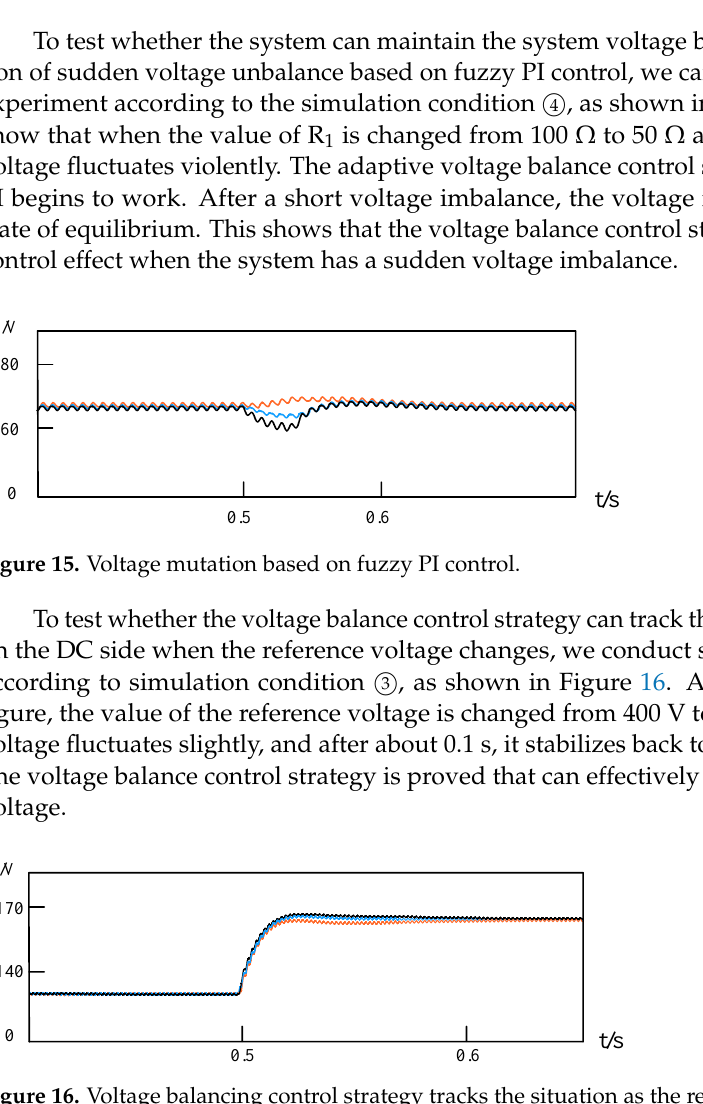
Figure 14. Voltage balance strategy under fuzzy PI control.